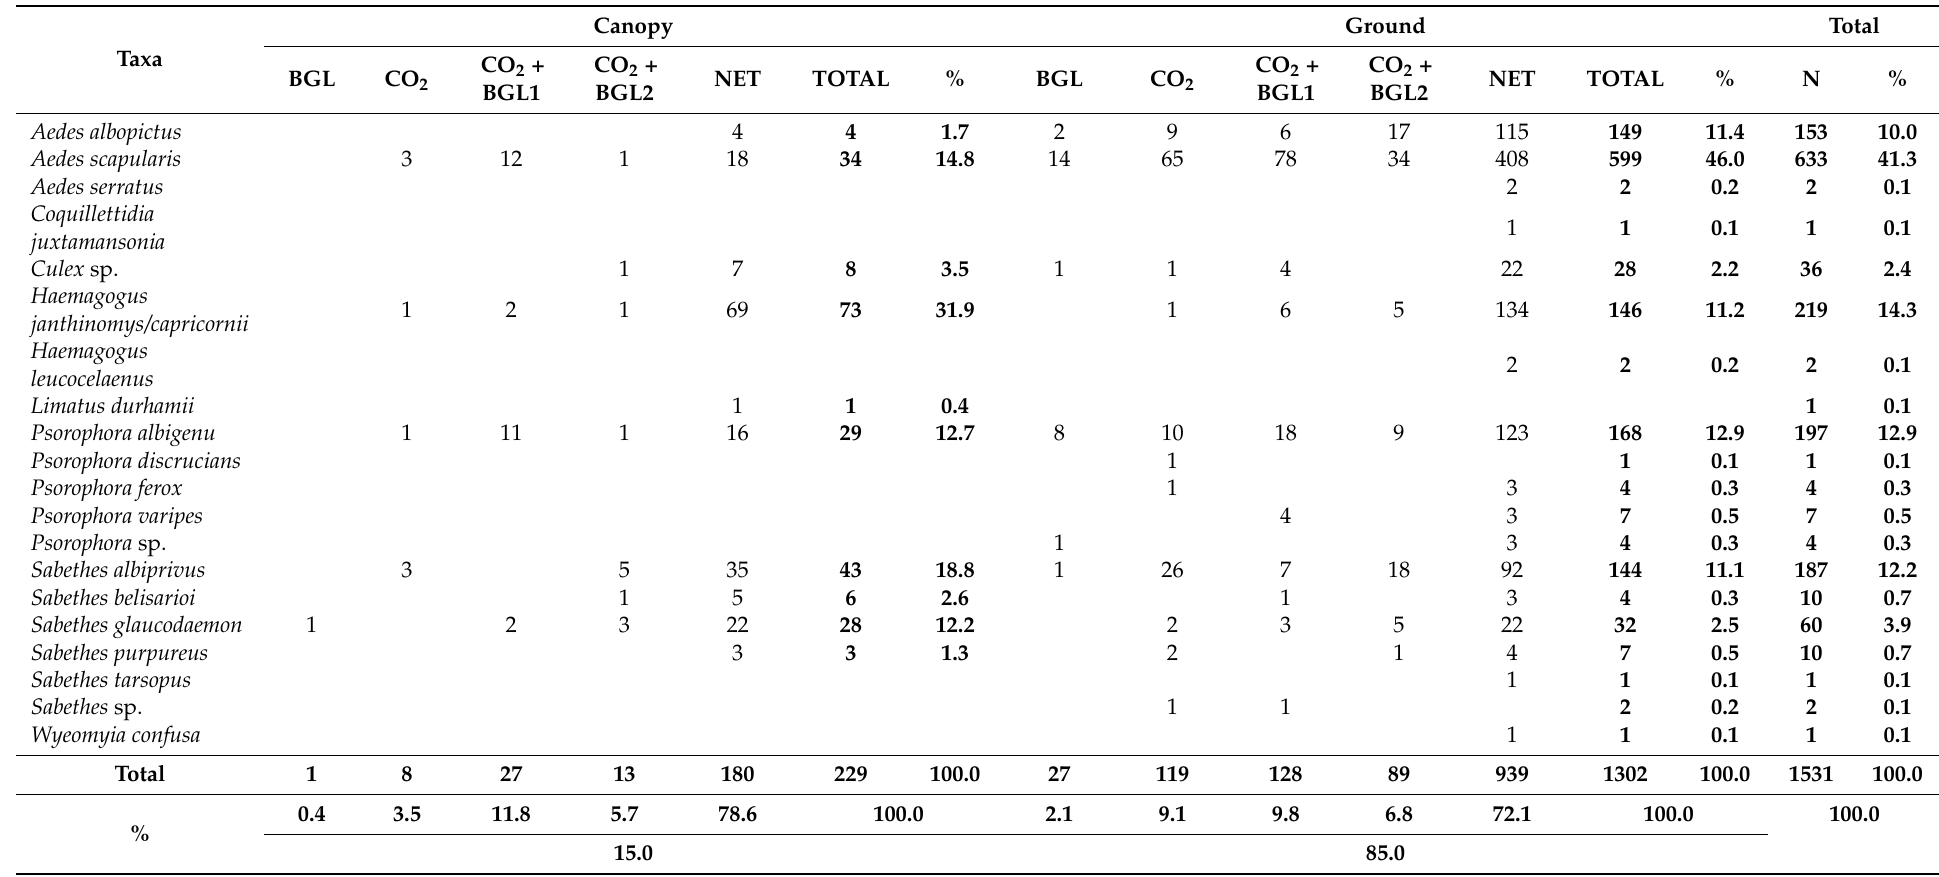
Table 1. Number of Culicidae females collected in the “P é -do-Gigante” sector of the Vassununga State Park, by forest stratum, technique, and